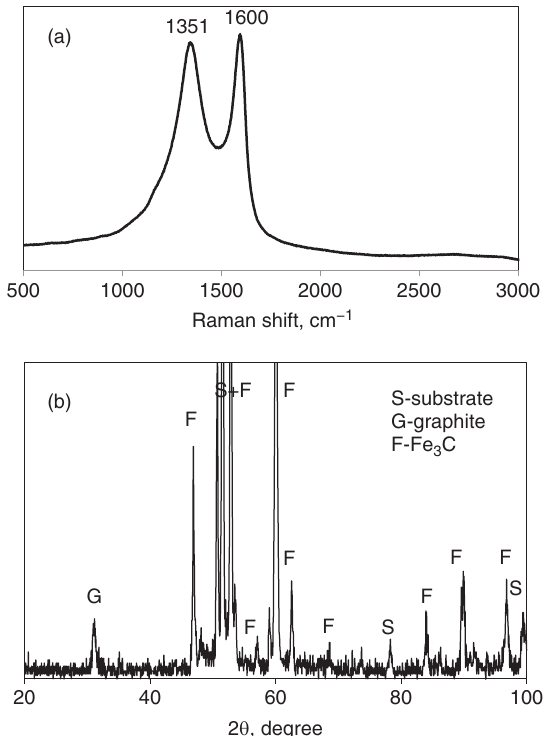
Figure 2: Raman spectrum (a) of the surface deposits and XRD patterns (b) of Kovar alloy substrate after MPCVD deposition in CH 4 /H 2 mixture.